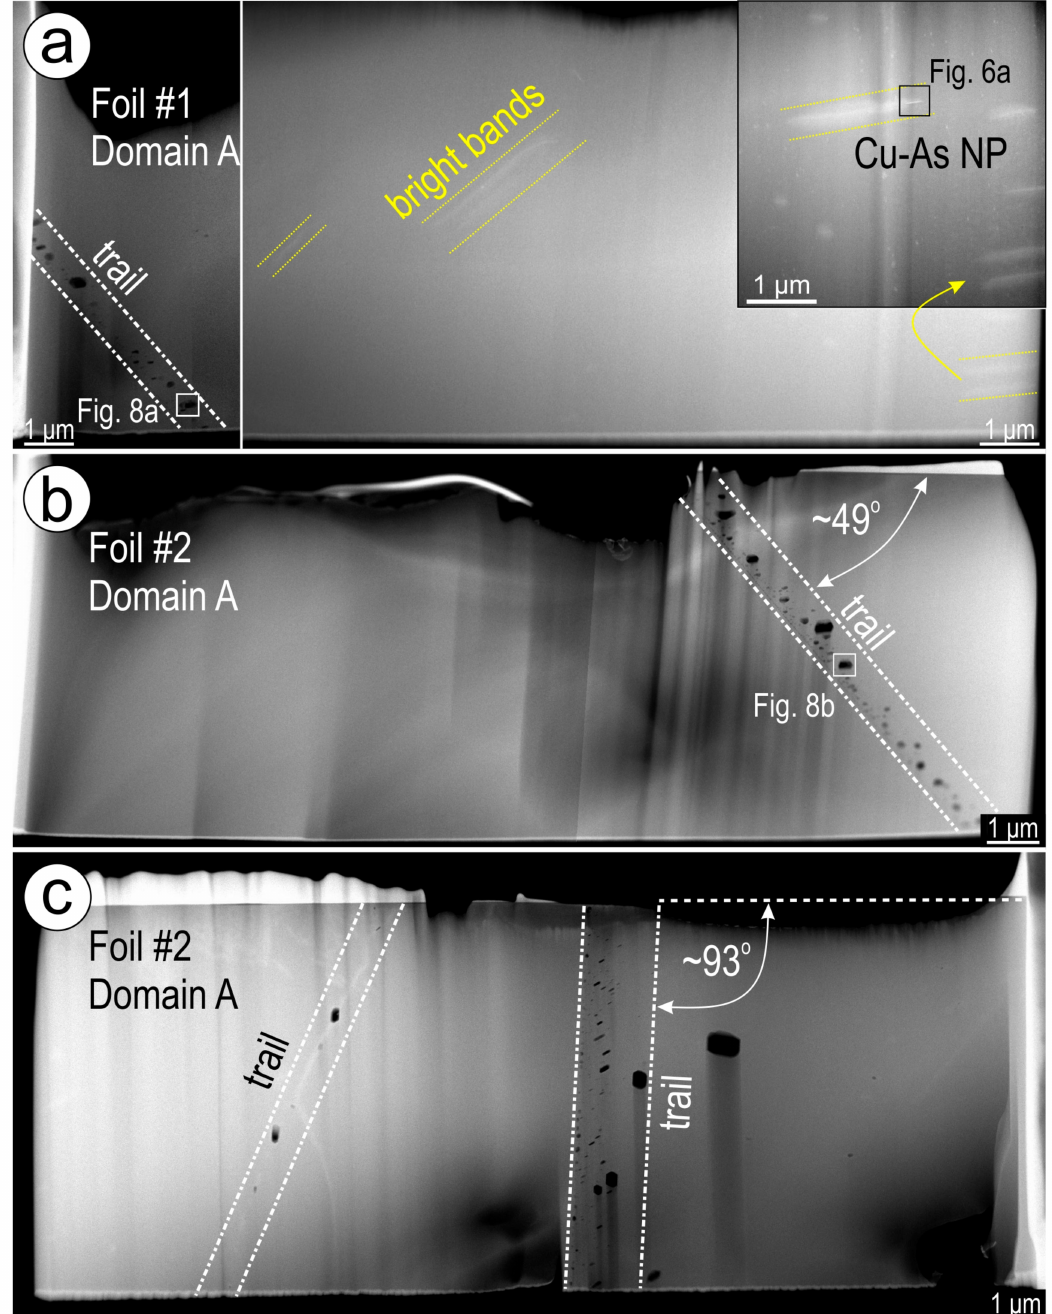
Figure 3. ( a – c ) HAADF STEM images of foils from grain 1 (foils #1–3) showing textures of Cu-As-zoned hematite. Trails of inclusions and cavities (white lines) with (sub)vertical orientation di ff er to (sub)horizontal, bright bands (yellow lines) observed in domain A. Inset in ( a ) shows one of the Cu-As NP along the “bright bands”. Note that the foils are oriented from the core of the hematite grain (left) to its margin (right) in all cases for comparison with the schematic shown as Figure